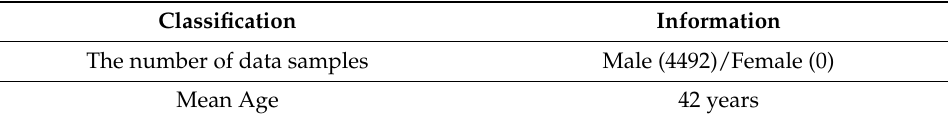
Figure 1. Examples of ( a ) images and ( b ) annotation information in the dataset. Table 1. Demographic information of the dataset.